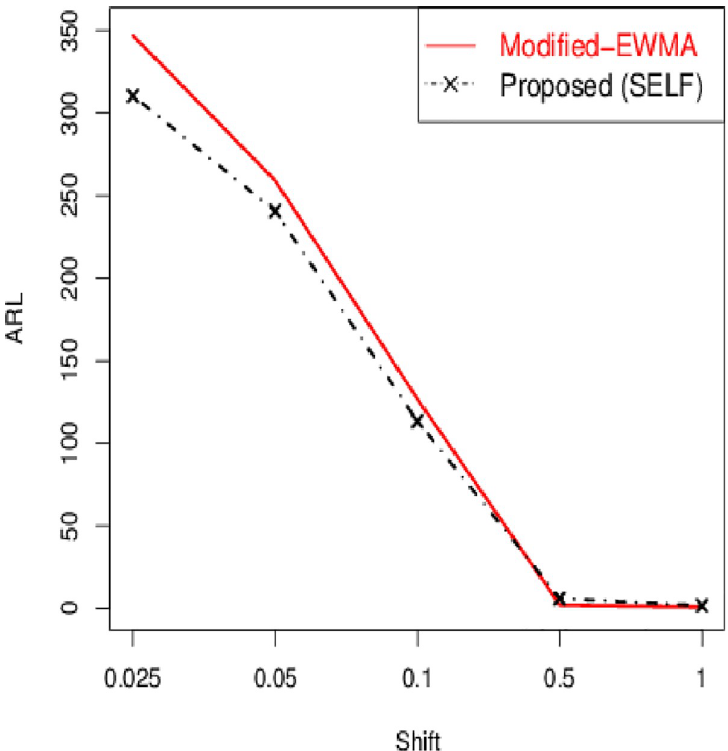
Fig 6. ARL comparison of proposed Bayesian Modified-EWMA chart (under SELF) with existing Modified- EWMA chart for n = 5 and λ = 0.30.